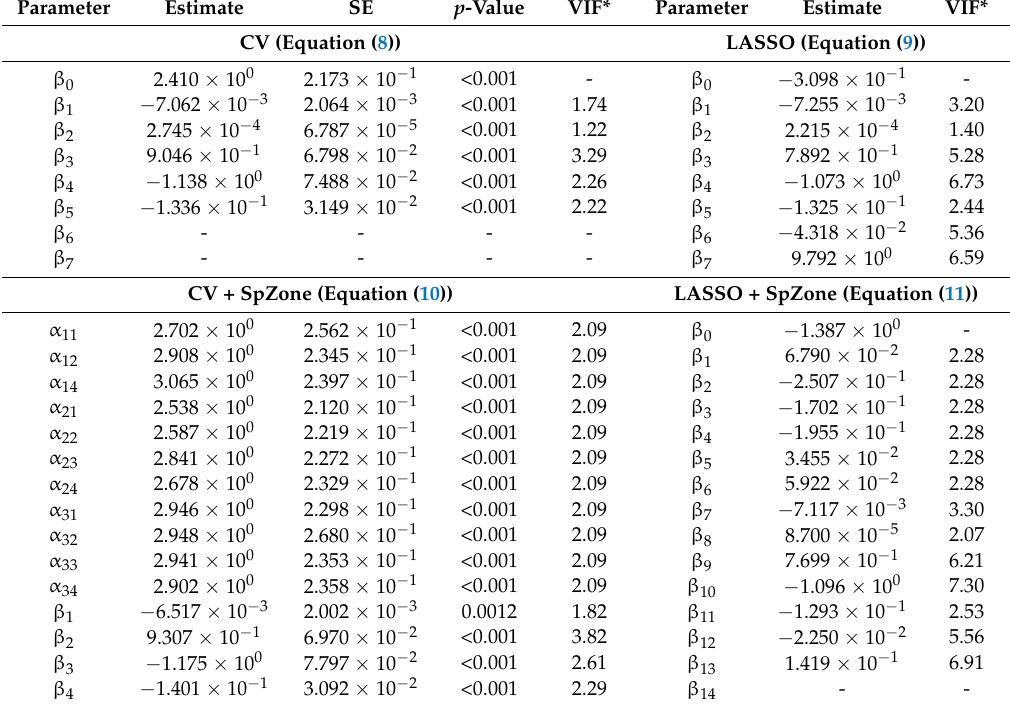
Table 2. Parameter estimates of selected models for estimation of the logarithm of annual increment in diameter at breast height (AIDBH, mm year − 1 ) for cross-validation (CV) and least absolute shrinkage and selection operator (LASSO) procedures.